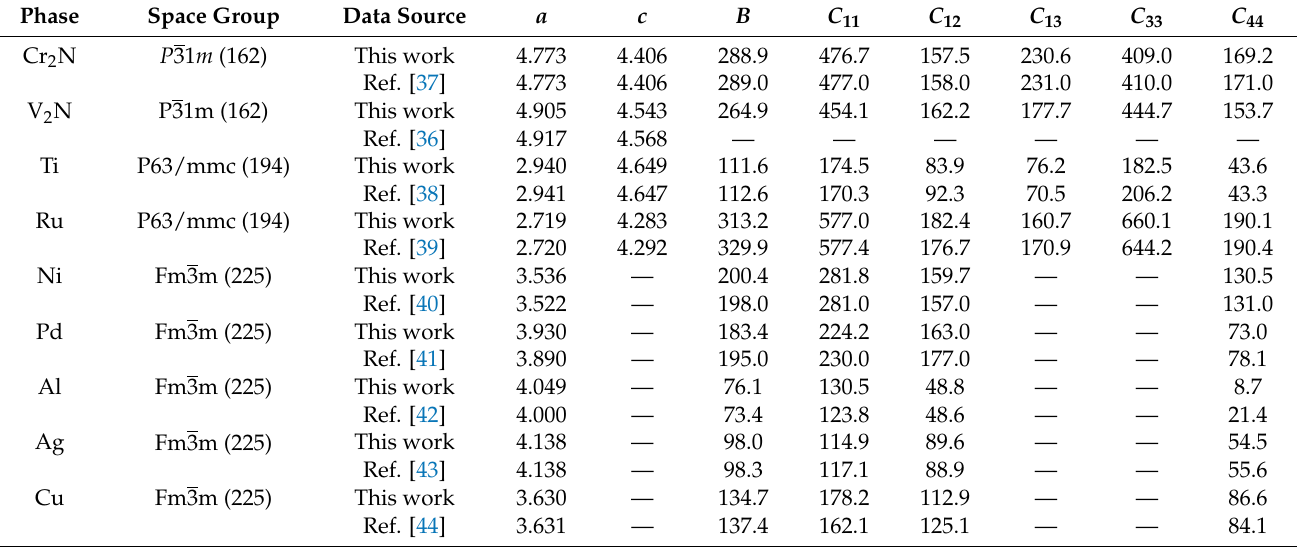
Table 1. Calculated lattice constant ( a and c , in Å), bulk modulus ( B , in GPa), and elastic